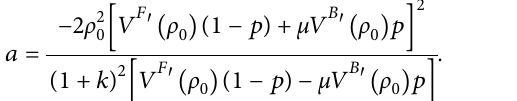
The solid and dashed lines represent coexistence and neutral stability curves, respectively. The solid and dashed lines of the same color in Figure 1 correspond to the same parameter value. The curve in the figure divides the space into a stable region, metastable region, and unstable region. � 2 In Figure 1, the parameter is set as v max